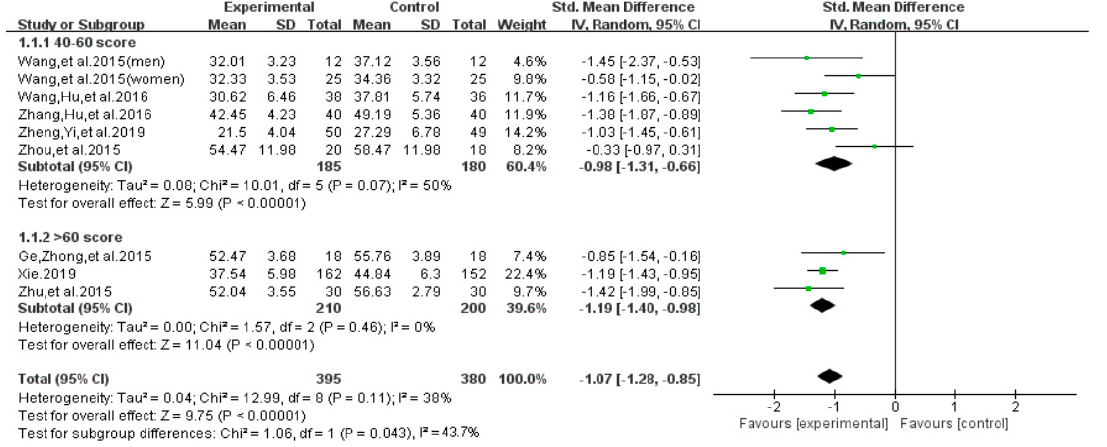
Figure 12. E ff ects of exercises on level of smartphone Figure 12. Effects of exercises on level of smartphone addiction.